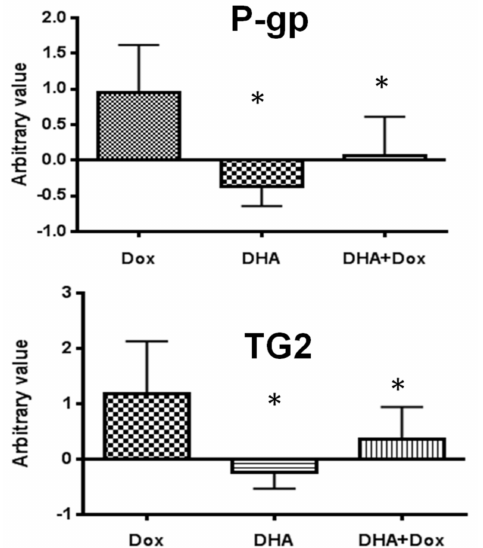
Figure 4. Effect of DHA on P-gp and TG − 2 gene expression in MCF-7/Dox cells. MCF-7/Dox cells were treated with doxorubicin (Dox) (2 µ M), DHA 50 µ M, alone or in combination for 48 h. RNA was extracted and evaluated for gene expression through real-time RT-PCR. * A p -Value of less than 0.05 is considered significant when compared to the control group treated only with Dox, as determined by a one-way